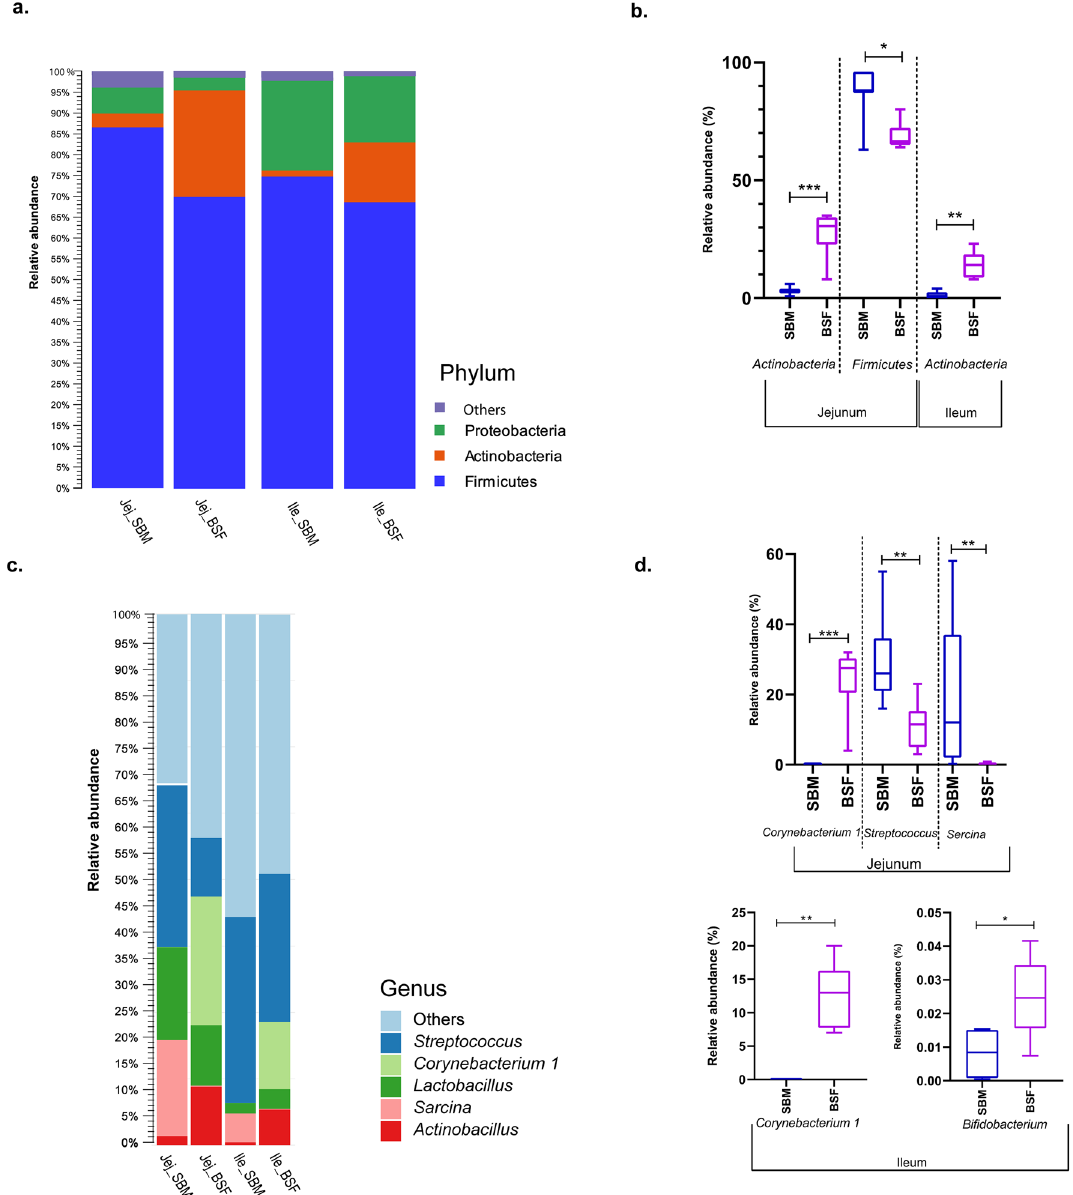
Figure 3. Bacterial abundances in digesta from jejunum and ileum of pigs fed a diet with either soybean meal (SBM) or black soldier fly (BSF) as single protein source. ( a ) Top three bacteria classified at phylum level. ( b ) Relative abundance of amongst the top three bacteria at phylum level that differ significantly between digesta collected from jejunum and ileum of pigs fed SBM and BSF based diet. ( c ) Top five bacteria classified at genus level. ( d ) Relative abundance of amongst the top five bacteria at genus level along with the relative abundance of Bifidobacterium that differed significantly among digesta collected from jejunum and ileum of pigs fed the SBM or BSF based diet. *** P value < 0.0005, ** P value < 0.005, * P value <